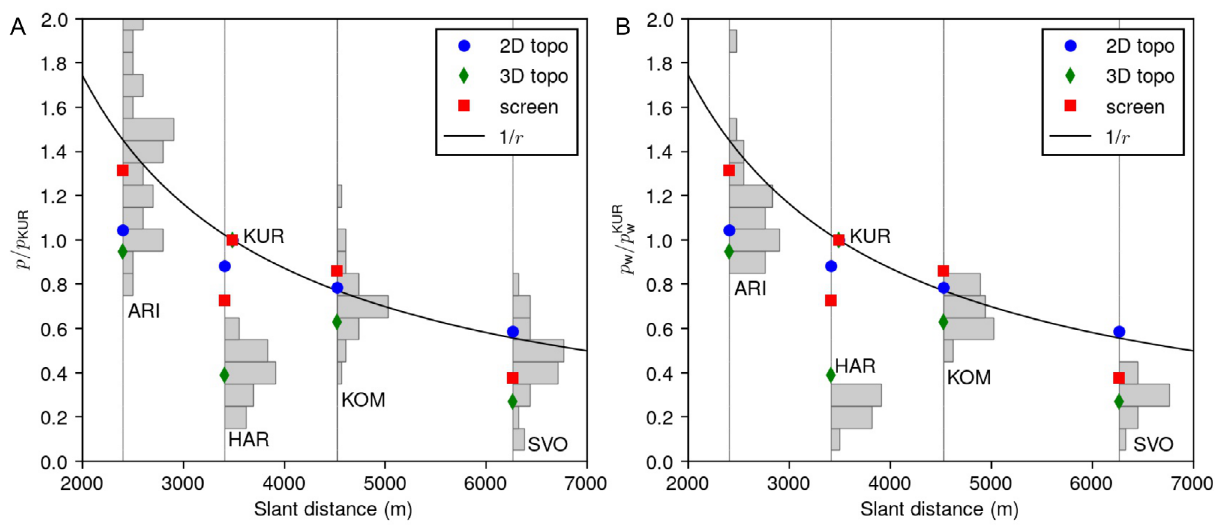
Figure 8: [A] Comparison of relative peak pressure values between observations and results from all methods (2D modeling, 3D modeling, screen predictions, and spherical spreading). Values are normalized by peak pressure at KUR to show relative amplitude distributions across the network. Histograms show the distribution of observed values at each station in bins of 0.1 p { p KUR . [B] As for Figure 8A but using the Fourier amplitude at 0.5 Hz ( p w ) instead of peak pressure. Note that vertical gray lines indicate zero counts in the histogram bins.